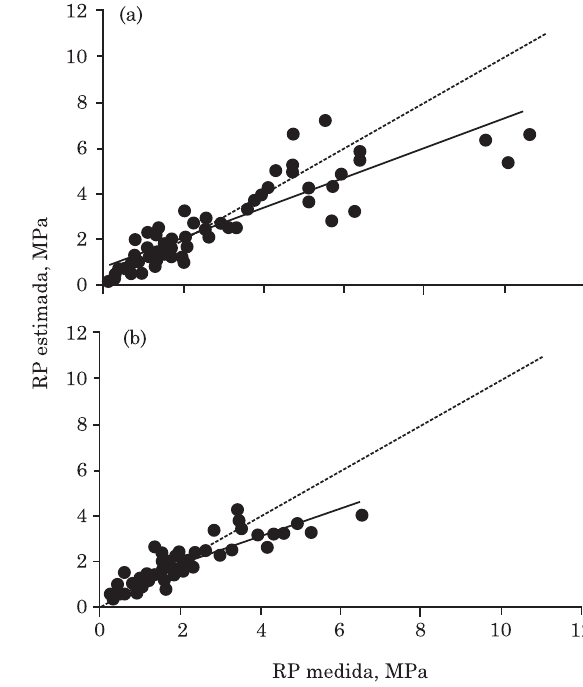
Figura 1. Distribuição dos valores de densidade do Figura 2. Resistência do solo à penetração (RP) solo (a), resistência do solo à penetração (b) e medida e estimada, utilizando as estratégias conteúdo de água (c) para as estratégias USUAL USUAL (a) e CAMPO (b). A linha tracejada e CAMPO. corresponde à relação Quadro 2. Equações ajustadas para a curva de resistência do solo à penetração (CRS) e para a curva de retenção de água (CRA), em que RP é a resistência do solo a penetração;   , conteúdo volumétrico da água do solo; Ds, densidade do solo e   , o potencial de água no solo